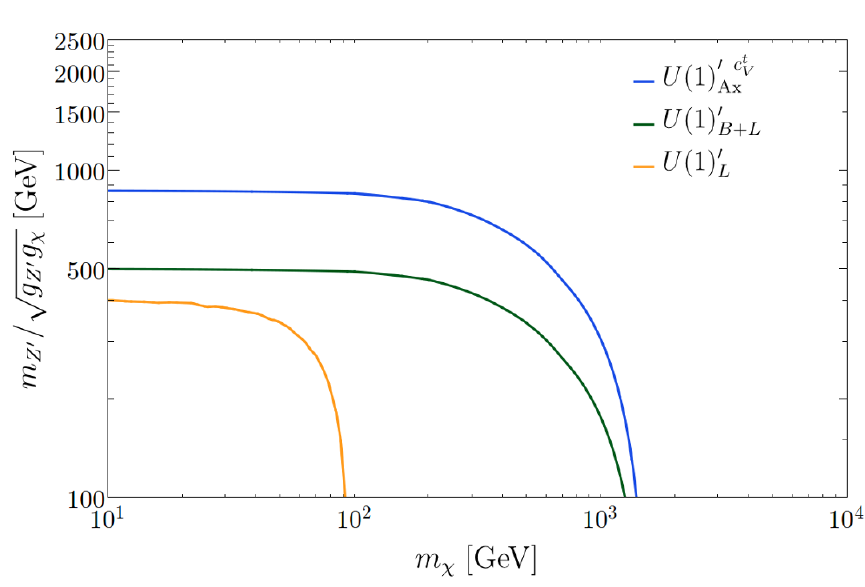
t ), and V ax and U(1) 0 B + L model. L